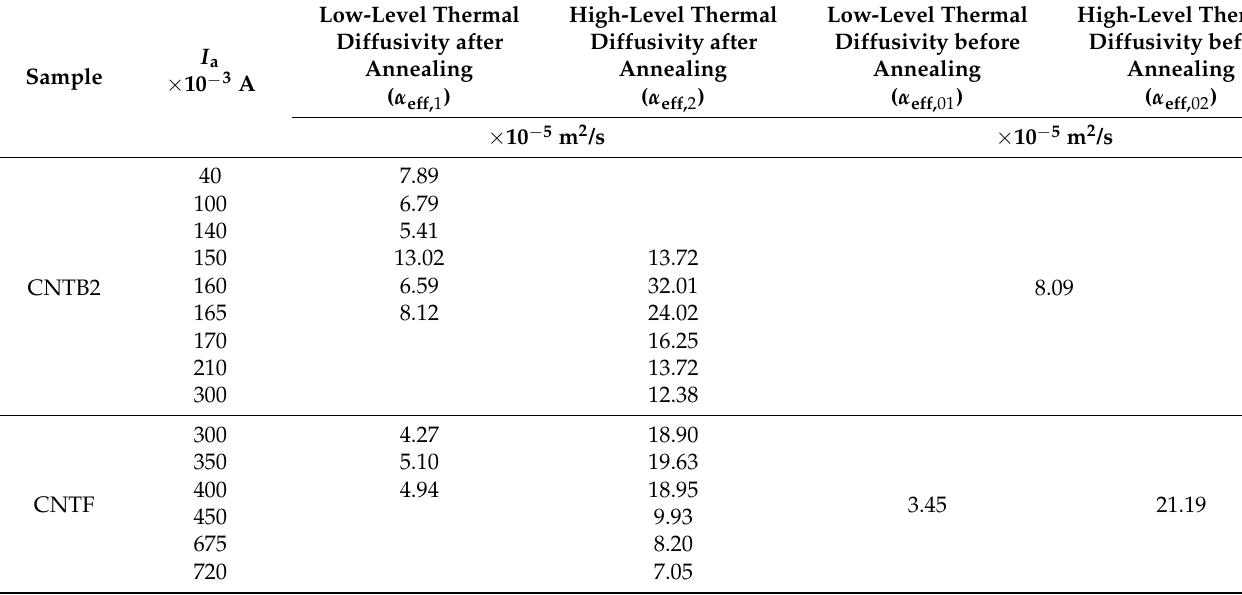
Figure 4. The curve of thermal diffusivity with an annealing current ( I a ): ( a ) CNTB2; ( b ) CNTF. Table 2. Partial experimental results of CNTB2 and CNTF during current annealing.